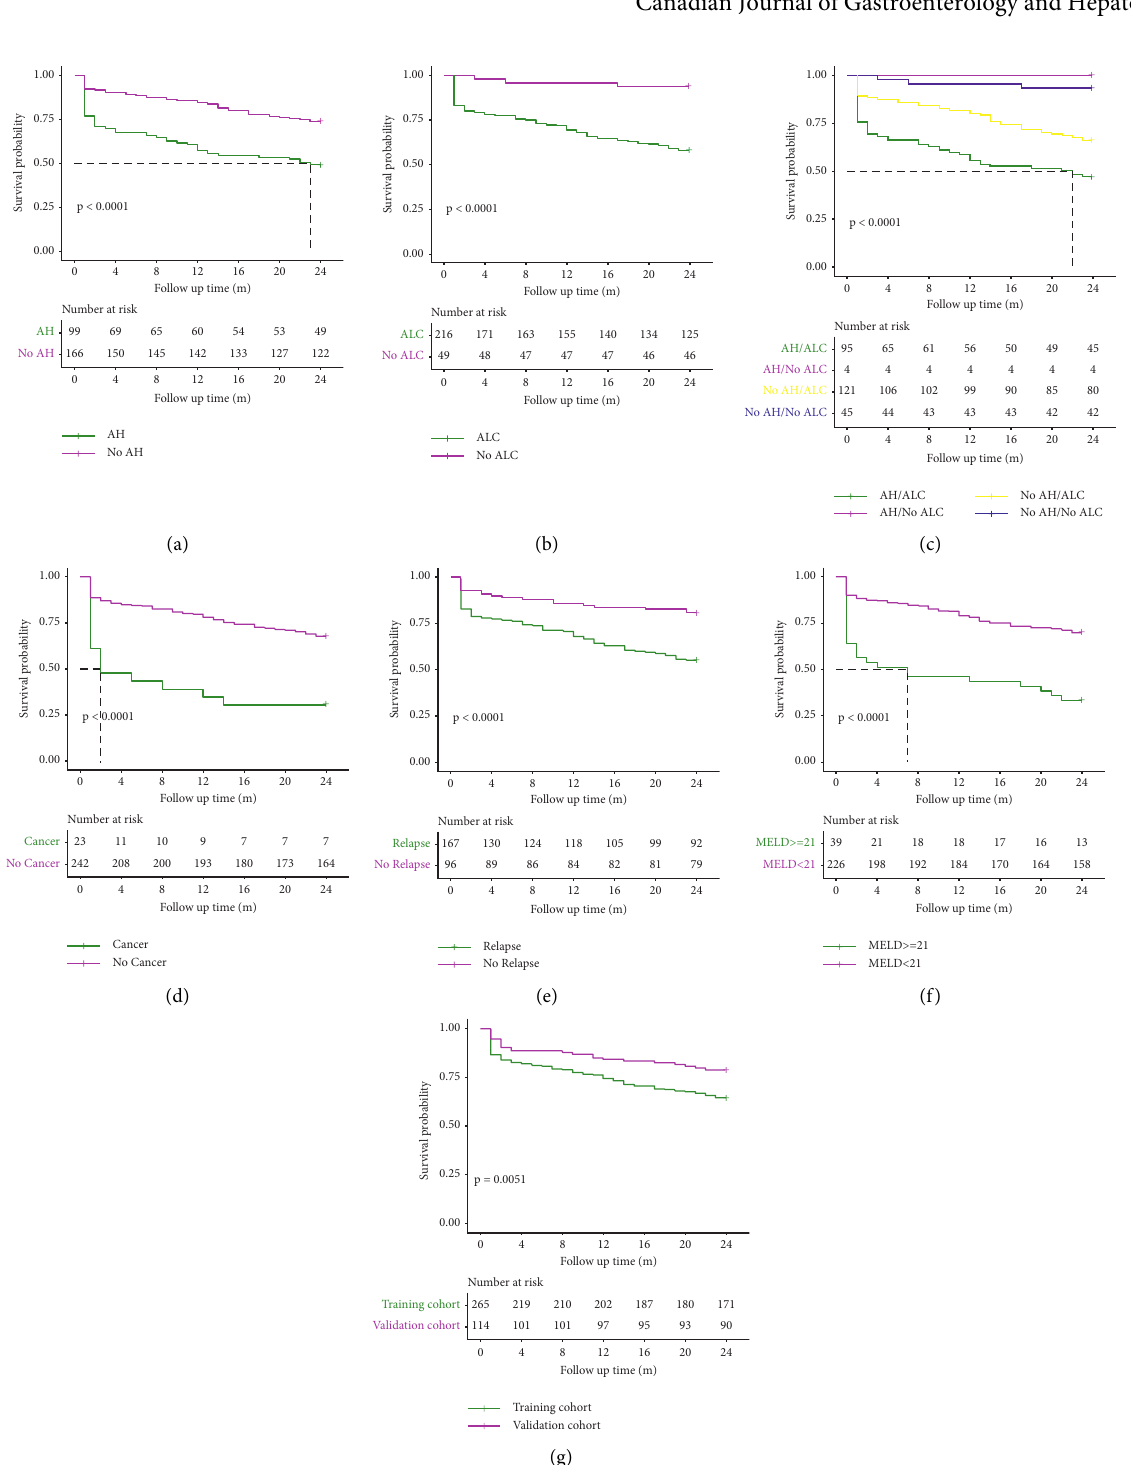
Figure 2: Kaplan–Meier estimate of the ALD patients stratified by cohort. AH/No ALC: patients with alcoholic hepatitis and without cirrhosis due to alcohol-related liver disease; No AH/No ALC: patients with neither alcoholic hepatitis nor cirrhosis due to alcohol-related liver disease; No AH/ALC: patients with cirrhosis due to alcohol-related liver disease and without alcoholic hepatitis; and AH/ALC: patients with both alcoholic hepatitis and cirrhosis due to alcohol-related liver disease. Kaplan–Meier curves for survival of patients with AH and without AH in the training cohort (a); Kaplan–Meier curves for survival of patients with ALC and without ALC in the training cohort (b); patients were divided into four groups, namely, AH/No ALC, No AH/No ALC, No AH/ALC, and AH/ALC. Kaplan–Meier curves for survival of the patients in the training cohort (c); Kaplan–Meier curves for survival of the patients with liver cancer and without liver cancer in the training cohort (d); Kaplan–Meier curves for survival of patients who followed abstinence and relapsed from abstinence in the training cohort (e); Kaplan–Meier curves for survival of the patients with MELD score ≥ 21 and with MELD < 21 in the training cohort (f); Kaplan–Meier curves for survival of the patients in the training cohort and validation cohort